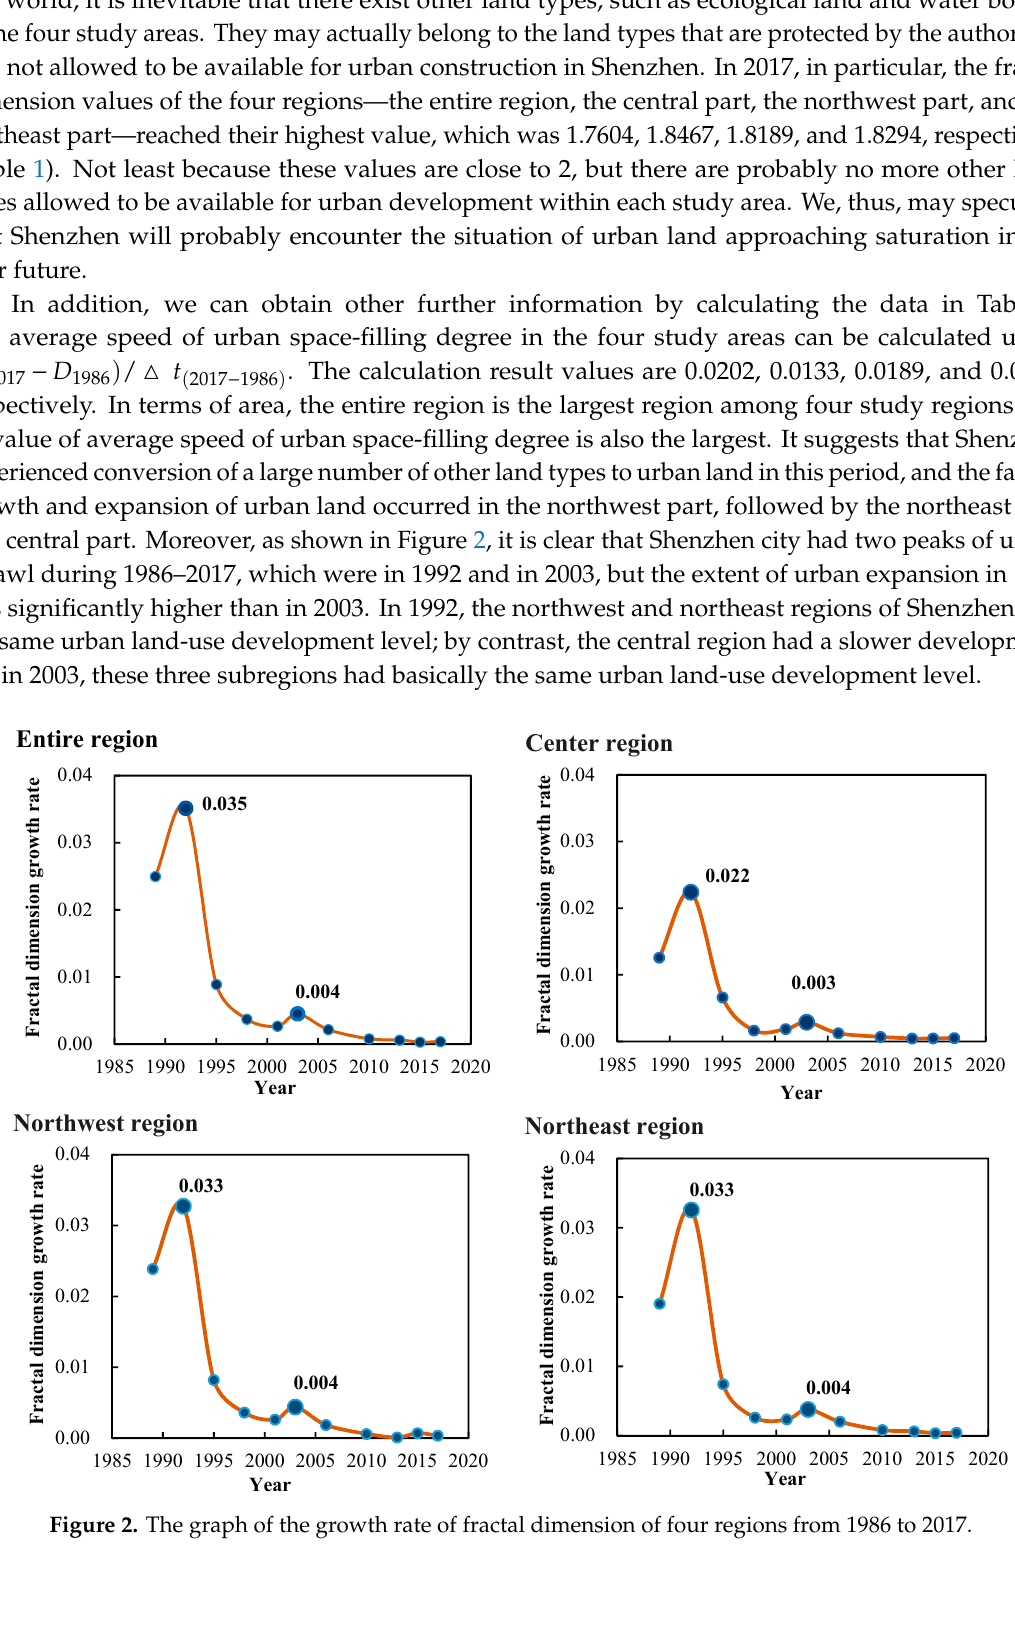
Table 1. Fractal dimension estimates of the urban form of four regions in Shenzhen, 1986–2017. Entire Region Center Region Northwest Region Northeast Region Year